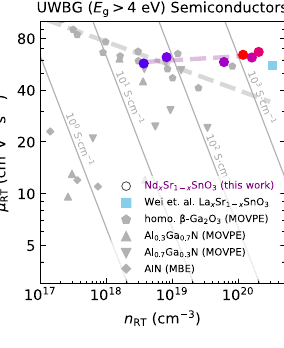
Correction Fig. 2: new fi gure